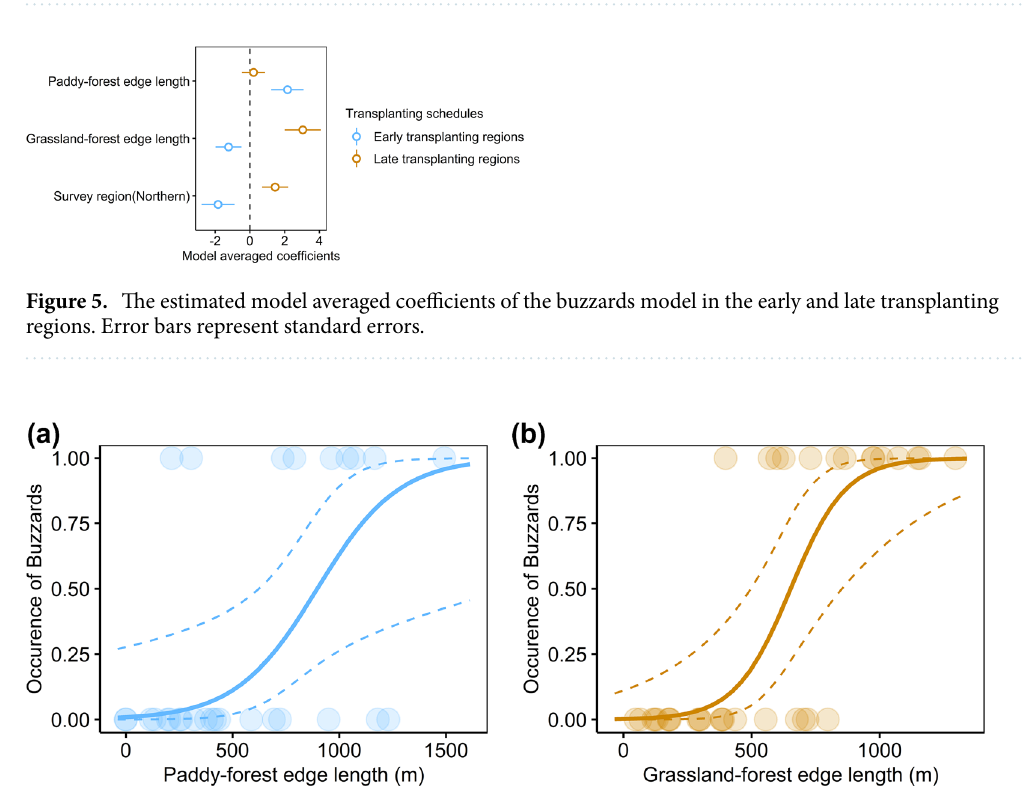
Figure 6. ( a )The relationship between breeding buzzards and paddy-forest edge length in early transplanting regions, and ( b ) the relationship between breeding buzzards and grassland-forest edge length in late transplanting regions. Dots represent the data of each blocks. The solid lines represent the regression curve estimated from the smallest AIC model in the early and late transplanting regions and the dotted lines represent the 95% credible